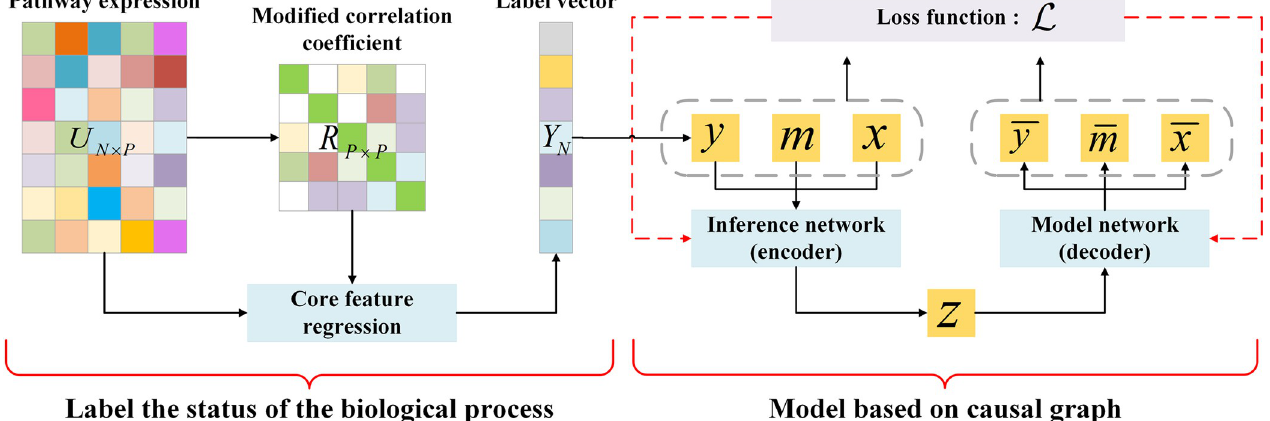
Fig 2. An illustration of the proposed framework. The biological process activity of each sample is obtained by core genes regression and used as the outcome of the casual model. The casual model consists of an inference network to calculate the mean and variance of P ( Z | X , y , m )and a model network to recover P ( Z , X , y , m